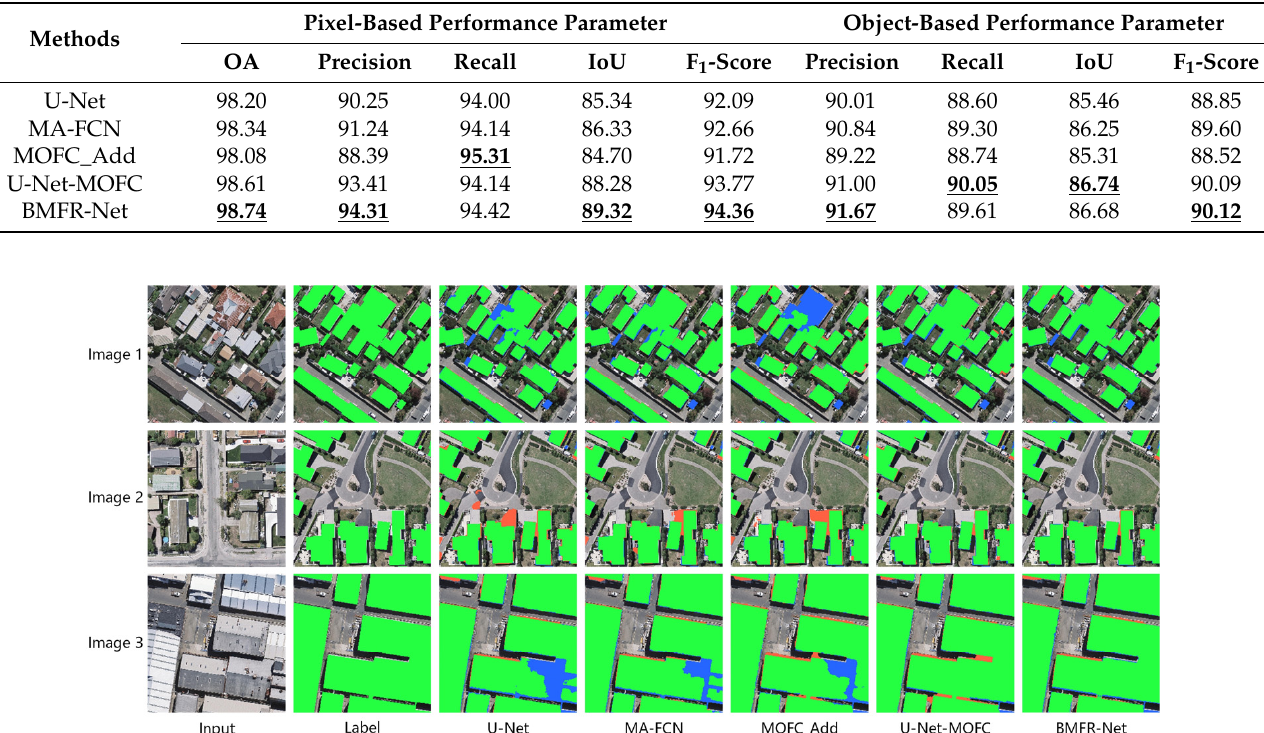
Figure 16. Two other kinds of multiscale output fusion constraint structures: ( a ) structure diagram of MA-FCN; ( b ) structure diagram of MOFC_Add. Table 5. Quantitative evaluation (%) of U-Net with different multiscale output fusion constraint structures. The best metric value is highlighted in bold and underline.